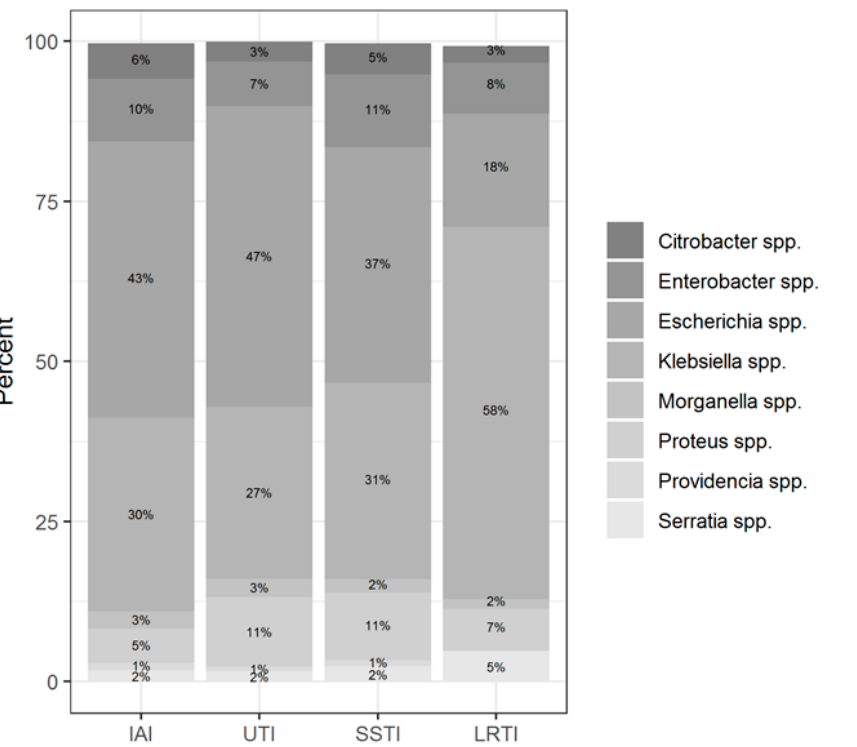
Figure 2. Distribution of the isolates according to infection localization.